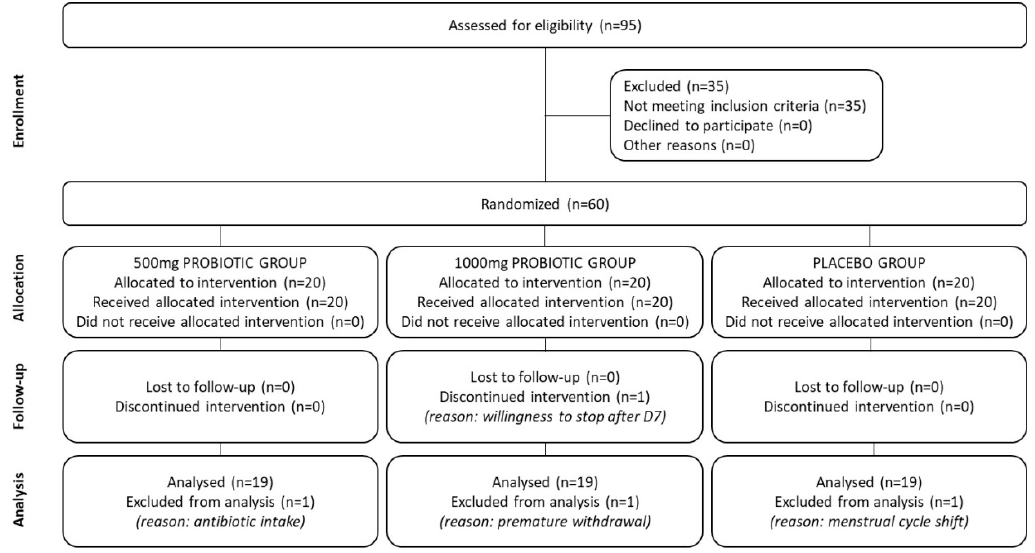
Figure 2. CONSORT iagram of the clinical study. Clinical study diagram according to Consolidated Standards of Reporting Trials (CONSORT)